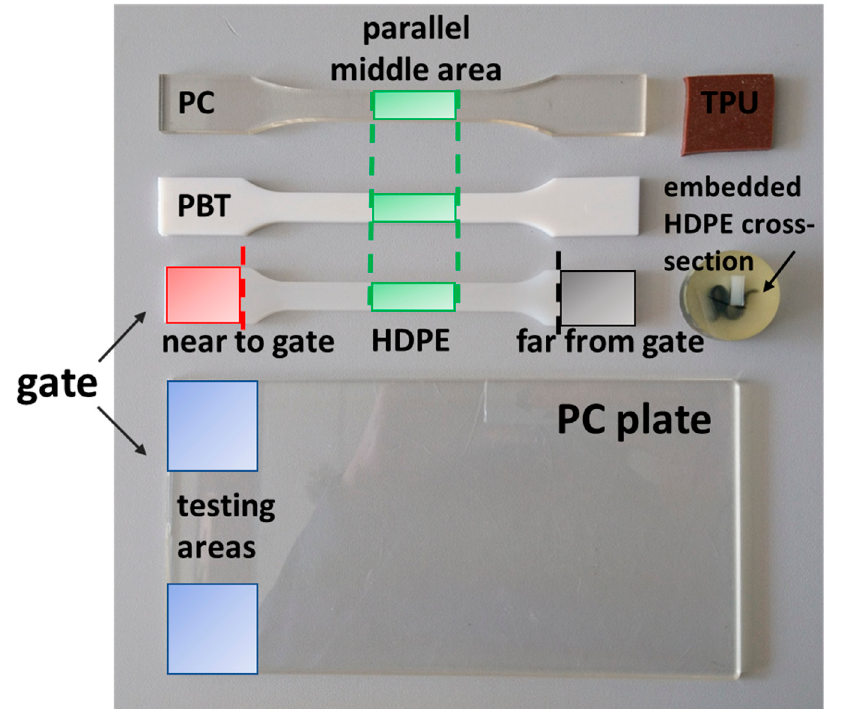
Figure 1. Photograph of sample positions for the different materials.